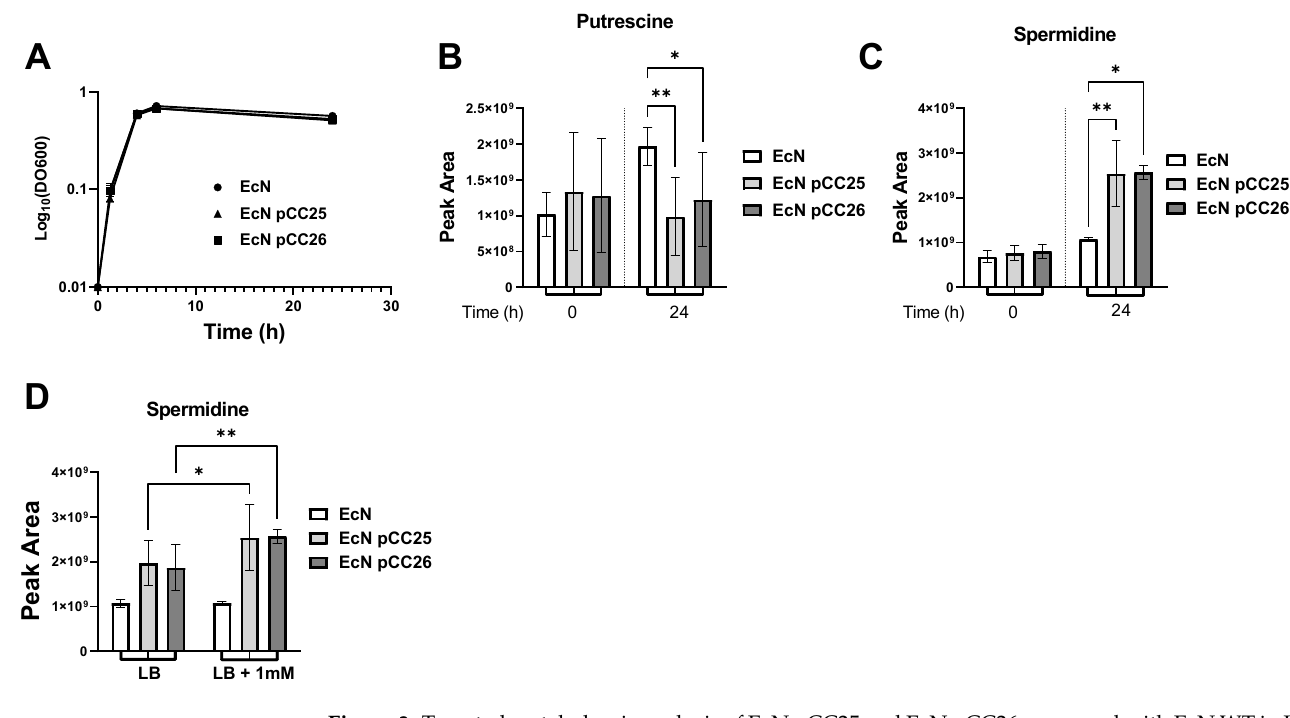
Figure 3. Targeted metabolomic analysis of EcN pCC25 and EcN pCC26 compared with EcN WT in LB broth supplemented with 1mM of putrescine. ( A ) Growth curves of EcN, EcN pCC25 and EcN pCC26 in LB medium supplemented with 1mM of putrescine (n = 8). ( B , C ) Peak area of spermidine ( B ) and putrescine ( C ) measured by LC-MS in the culture supernatant of EcN, EcN pCC25 and EcN pCC26 at the beginning of the culture (0) or 24 h after the cultivation start (24) (n = 8). ( D ) Comparison of the signal obtained for spermidine at 24 h between our two culture conditions (LB and LB supplemented with 1 mM putrescine). The individual data were obtained from 8 independent cultures. All data shown represent the mean ± SD. Statistical significance was calculated using Kruskal–Wallis test and Benjamini, Krieger and Yekutieli Multiple comparisons. Statistical significance indicated as * p < 0.05, ** p < 0.01.